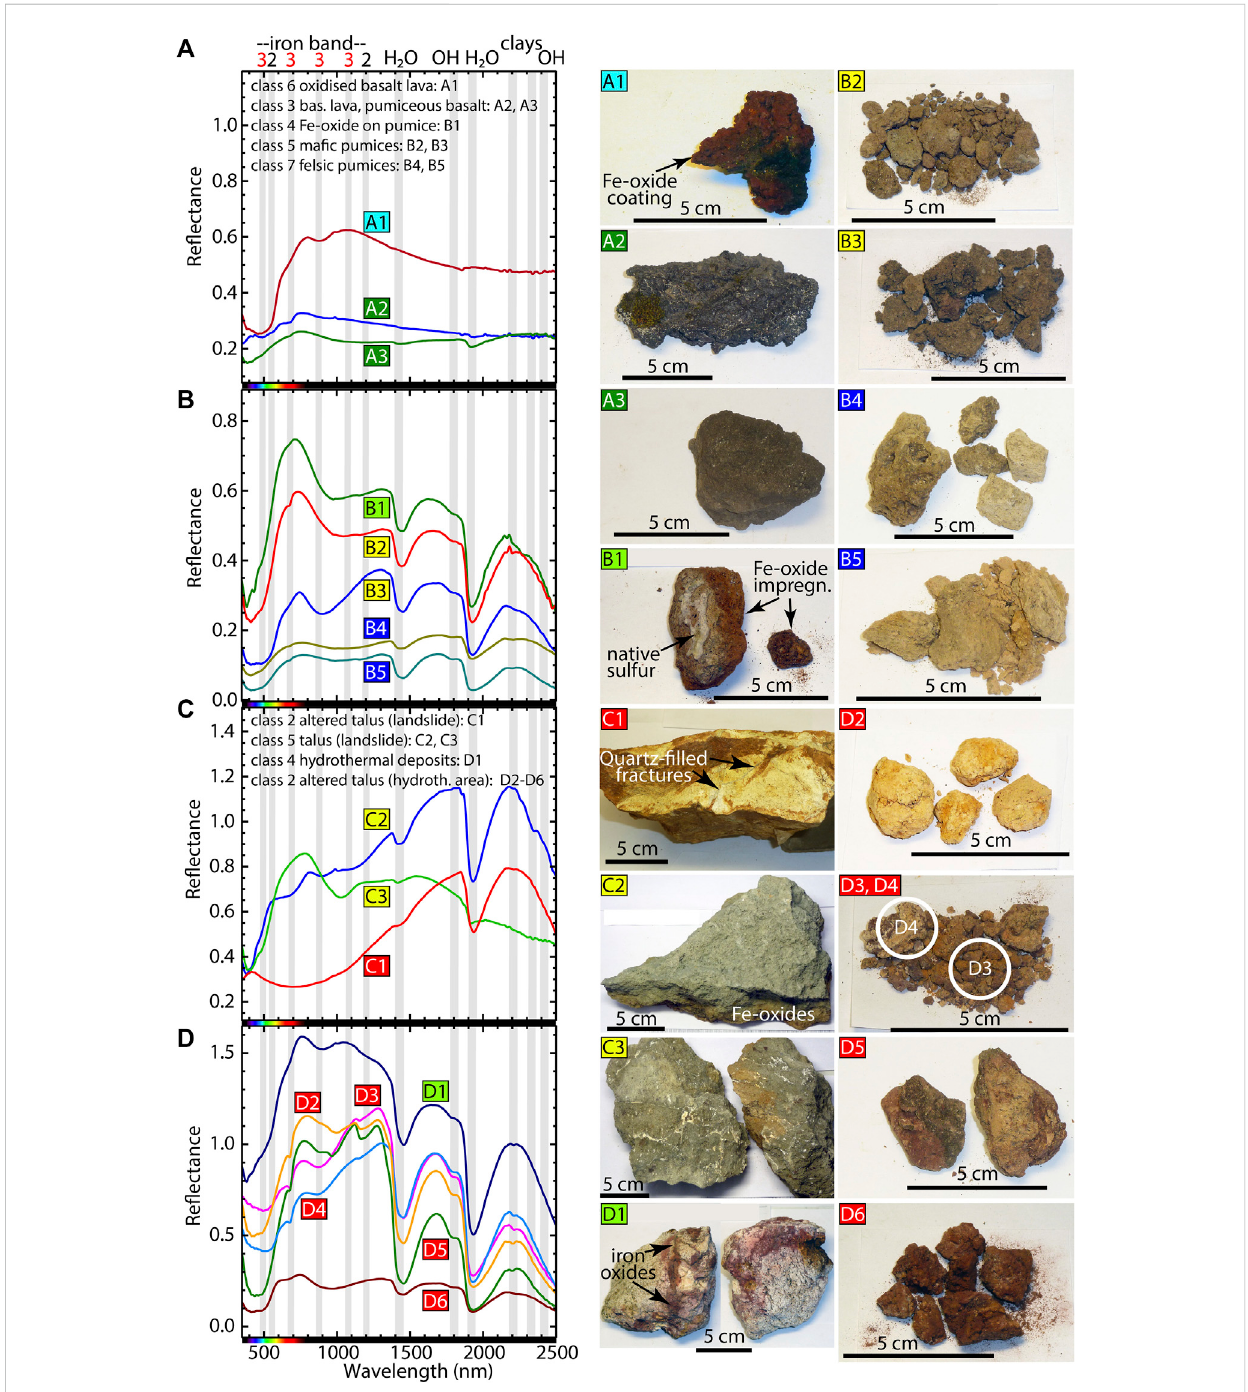
FIGURE 8 Spectra of rock samples acquired in the fi eld (left) and corresponding photos (right) attributed to the 6 different rock classes. Important absorption featuresareindicatedbylight-grayverticallines. (A) Spectraofblackbasalticmaterials. (B) Spectraofwhiteandgrayrhyoliticandbrownbasalticpumices. (C) Spectra of differently colored altered landslide materials and (D) spectra of hydrothermally altered material (mostly pumices in different alteration stages). (A1) Fe-oxidecoatedbasalticlava,withmm-sizedFeldspar phenocrysts. (A2) Backglassybasalticlava, withmm-sized Feldspar phenocrysts and overgrown with moss. (A3) Black-gray pumiceous basalt. (B1) Clayiferous brown-gray pumice substrate with Fe-oxide impregnations and native sulfur coatings. (B2) Clayiferous steel-gray pumice with partial Fe-oxide impregnation and native sulfur coatings (B3) Clayiferous “ earthy ” brown-gray pumice. (B4) Vesicular pale-gray pumice, brown-gray pumice, and white pumice. (B5) Vesicular brittle clasts of orange stained (hydrothermally affected) white pumice. (C1) Yellow-brownish piece of hydrothermally altered rhyolite with Quartz- fi lled fractures, possibly from the dome in the upper slope of the landslide. (C2) Greenish-gray hyaloclastite from the Austurffjöll. (C3) Greenish-brown brecciated basaltic hyaloclastite or pillow lava from the Austurffjöll. (D1) Clayiferousbleached “ whitetuff ” withFe-oxideimpregnation,possiblyapiecefromoneofthehydrothermalreplacementdepositsinthe NE caldera wall. (D2) Orange-yellow clay-rich white pumice. (D3+D4) . Yellow-brown to red-brown colored clayiferous gray pumice. (D5) Dark-brown Fe-oxide coated gray pumice. (D6) Fe-oxide coated pale brown obsidian